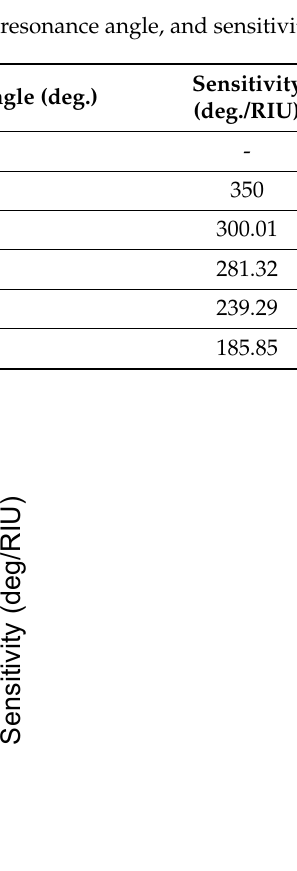
9 of 13 Figure 4. Sensitivity versus the number of Ti 3 C 2 T x sheets with various thicknesses of Ag layer at Si thicknesses of ( a ) 1, ( b ) 2, ( c ) 3, and ( d ) 4 nm. Small changes in the RI of the analyte lead to a significant shift in the angular position of the reflectance dip. We analyzed the resonance angle shift and sensitivity of the pro- posed sensor (Ag of 50 nm/Si of 4 nm/a monolayer of Ti 3 C 2 T x ) for varied fat concentrations (0.0%, 1.5%, 3.3%, 6.6%, 10%, and 33.3%) in milk. The fat concentrations in milk and the corresponding RI, angular position of the resonance dip, shift of the resonance angle, and sensitivity are summarized in Table 3. Figure 5 shows that any small change in the fat concentration, and hence in the RI, can be easily sensed, which reflects a shift in the reso- nance dip angular position. The figure also shows that increasing the fat concentration leads to a drop in the sensitivity of the sensor. The sensitivity is found to be 350, 300.01,